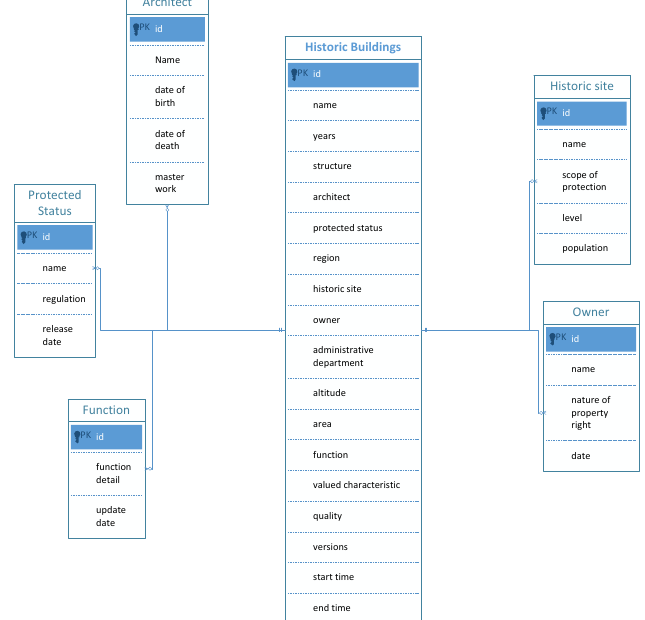
Figure 2. Star model of historical building